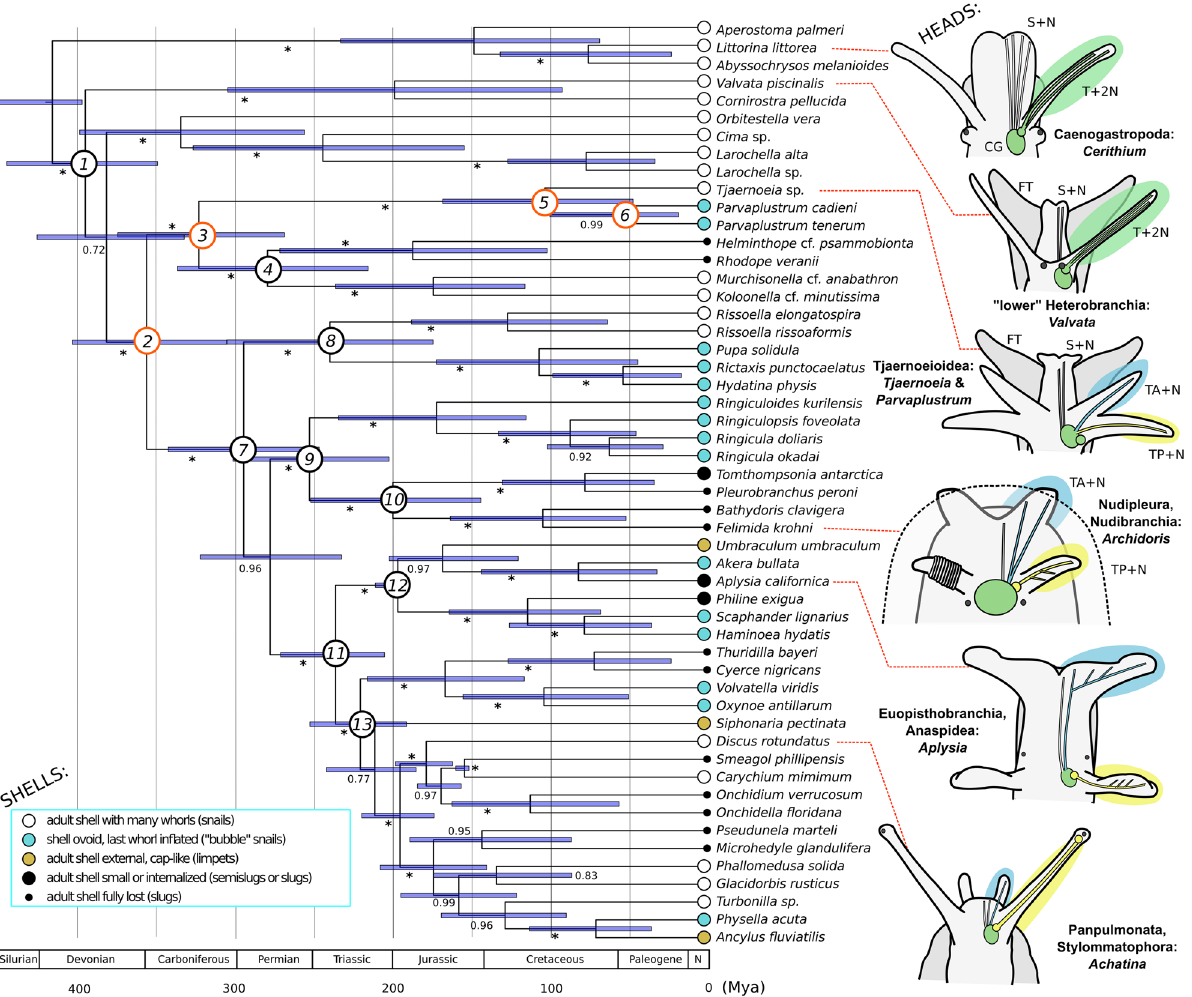
Figure 4. Time-calibrated phylogeny of heterobranch gastropods and distributions of different types of head and shell morphologies. Tree reconstruction was based on combined four-gene sequences and calibration priors placed on three nodes and performed in BEAST. Numerals on branches are Bayesian posterior probabilities; asterisks denote full support (PP: 1). Numbered circles at nodes indicate major clades, including (1) Heterobranchia, (2) Tetratentaculata nov., (3) Mesoneura nov., (4) Allomorpha, (5) Tjaernoeioidea nov., (6) Parvaplustridae nov., (7) Euthyneura , (8) Acteonimorpha, (9) Ringipleura, (10) Nudipleura, (11) Tectipleura, (12) Euopisthobranchia, and (13) Panpulmonata. Pictograms of head morphology suggest two pairs of tentacles existed at node 2 (hence new name Tetratentaculata: ‘bearing four tentacles’). Colour-coded circles at terminals show phenotypic plasticity of shells in Tetratentaculata, particularly in Euthyneura. Abbreviations: CG, cerebral/ cerebropleural ganglion; FT, foot; S + N, snout with snout nerves; T + 2N, single tentacle with two nerve cords (green area); TA + N, anterior/labial tentacle with one or two nerve pairs (blue area); TP + N, posterior tentacle or rhinophore/ommatophore with single nerve (yellow area). Head schemes of Aplysia, Archidoris and Achatina after 13 , anterior side is up. See Supplementary Fig. S3 for further